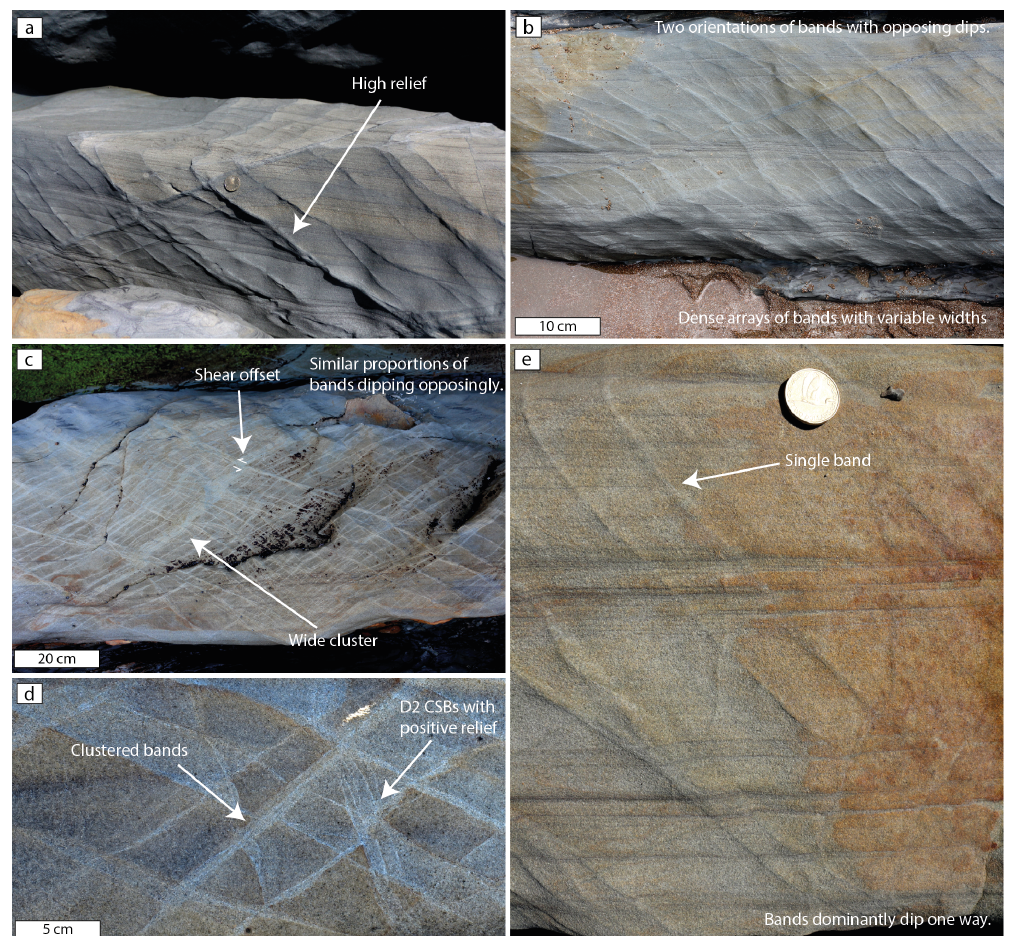
Figure 11. Field images of regularly spaced D3 SEBCs and D3 CSBs. CSBs are differentiated from SECBs by their millimetre- to centimetre- scale offset. Regularly spaced bands are primarily hosted within single sandstone layers and do not propagate into adjacent layers. (a) Two orientations of D3 SECBs with high relief that exhibit undulations along strike. (b) Two orientations of D3 SECBs. The D3 SECBs are dense and have variable thickness. Narrow SECBs with moderate relief sit between thicker SECBs and clusters. (c) Densely spaced D3 SECBs. Similar proportions of SECBs with each dip are observed. Through the centre of the image is a wide cluster of SECBs. CSBs with reverse- sense offset cut the cluster. (d) Wide clusters of D3 SECBs. The SECBs cut high-relief D2 CSBs. (e) Single-band SECBs that dominantly dip one way often with < 1mm or no macroscopic offset of sedimentary